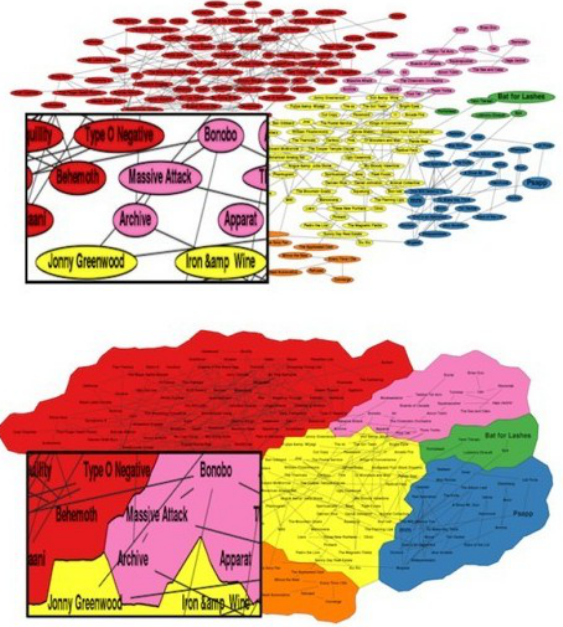
Figure 32. Saket et al. show two visualization of the same data: node-link diagram and map-based diagram [55]. Image courtesy of Saket et al.